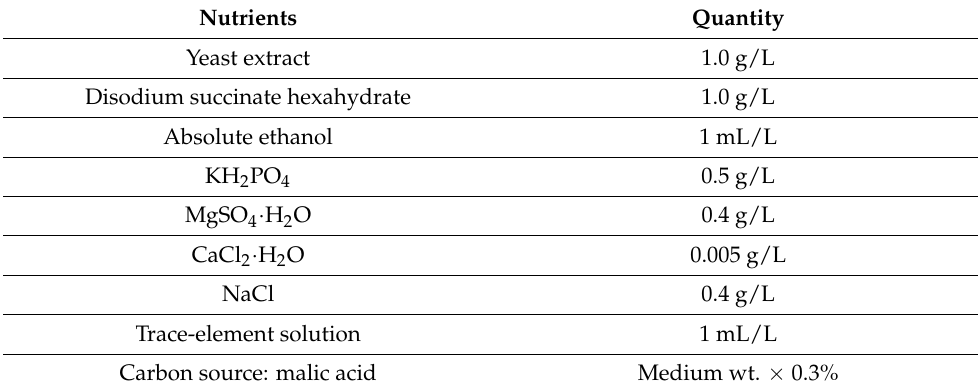
Table 3. Medium composition for culturing Rhodobacter capsulatus